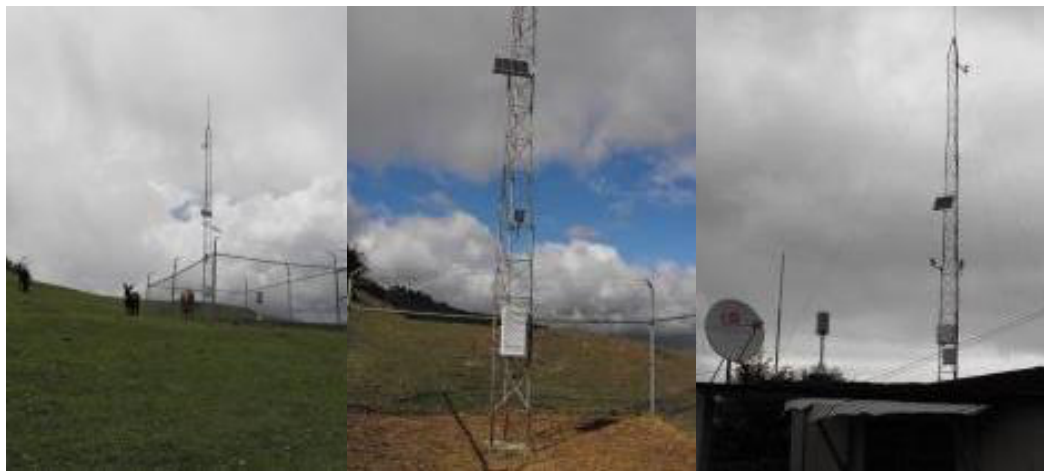
Figure 19. Photographs of the installed